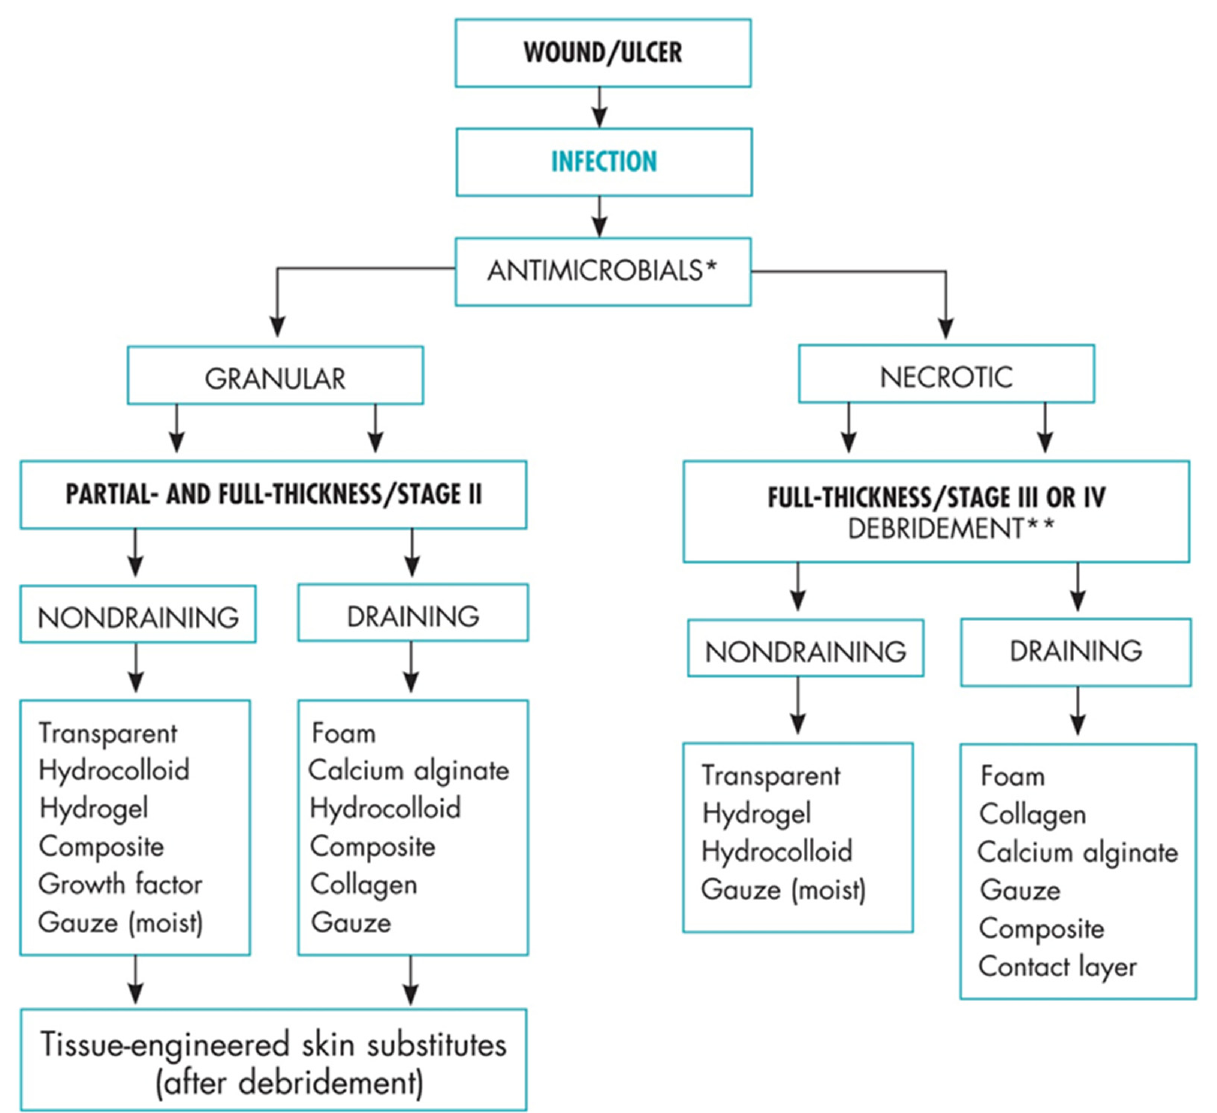
Figure 2. Wound treatment algorithm. * Antimicrobials may be topical or within a dressing component. ** Debridement may be done by surgical, mechanical, autolytic, or enzymatic methods. Adopted with permission from (©Baranoski, S., McIntosh, A., Montoya, L. Optimizing the use of Dressing, Lecture, Clinical Symposium on Advances in Skin and Wound Care. Las Vegas, NV, September 2014.).